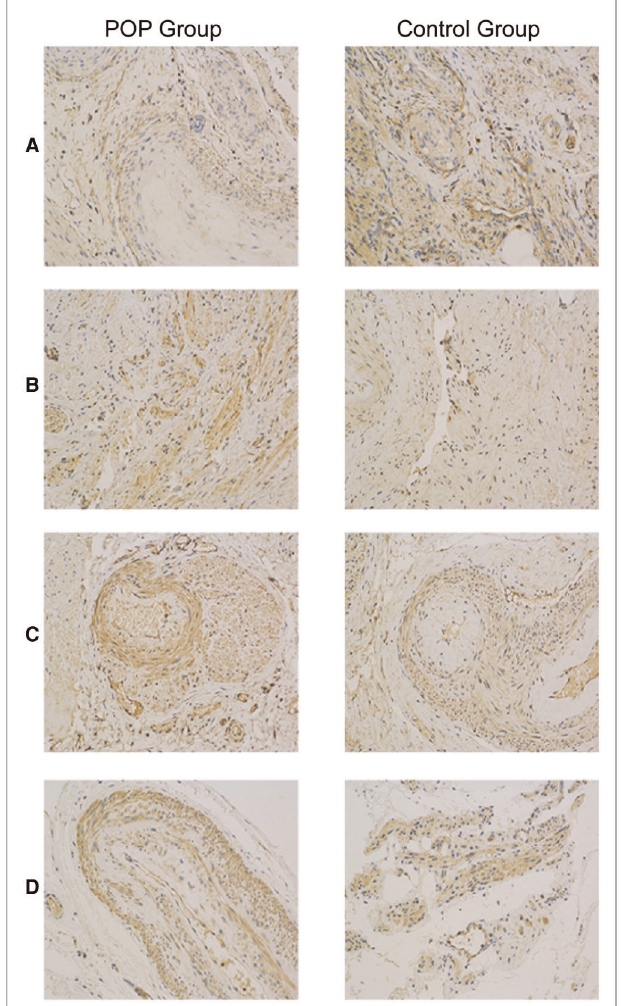
FIGURE 1 | Immunohistochemistry analysis of uterosacral ligaments from women with and without pelvic organ prolapse. Sections of uterosacral ligaments obtained from women who had undergone hysterectomy were stained with antibodies against CD44 ( A ), transforming growth factor- β ( B ), matrix metalloproteinase (MMP)-2 ( C ), and MMP-9 ( D